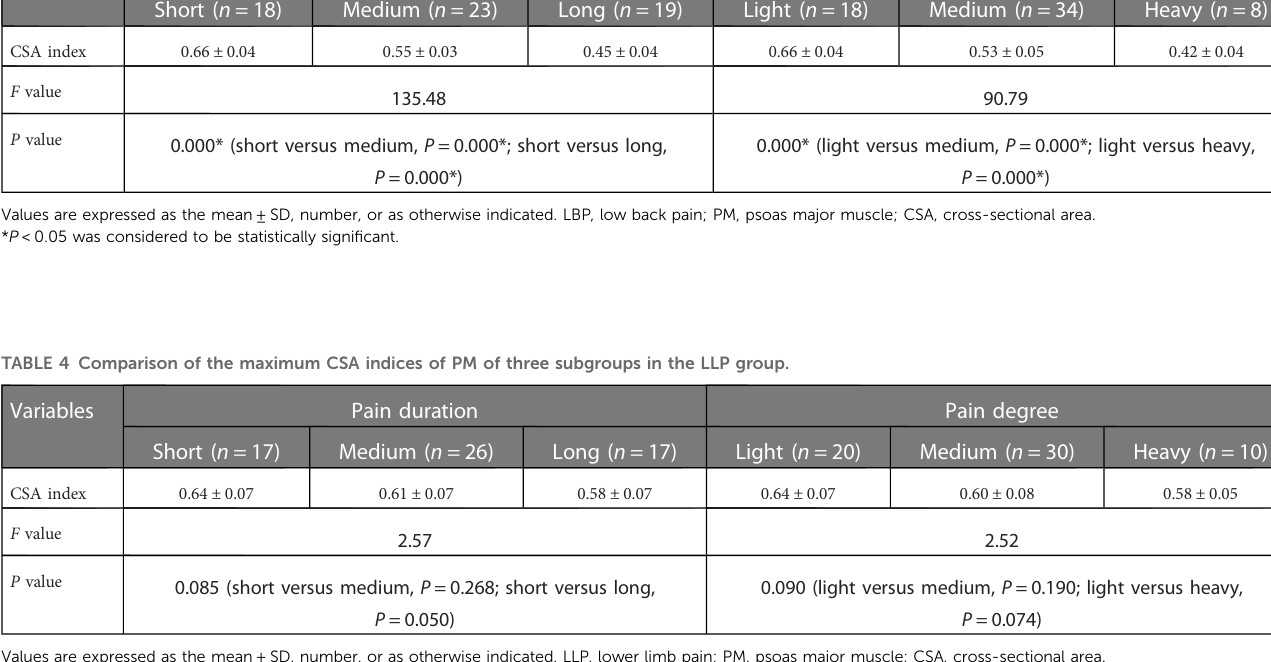
TABLE 3 Comparison of the maximum CSA indices of PM of three subgroups in the LBP group. Variables